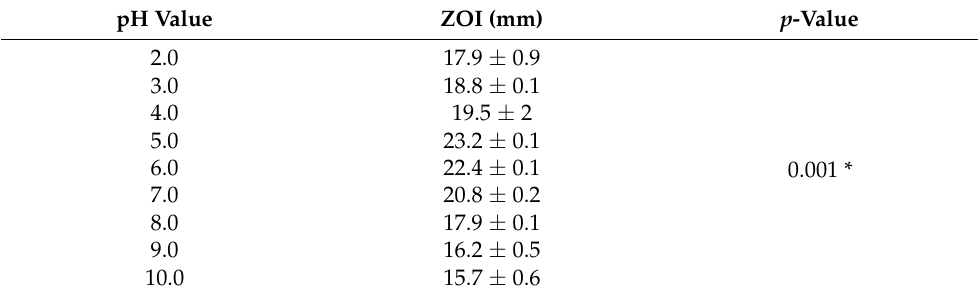
Table 2. Inhibitory effects of enterocin at various pH values against PA01.